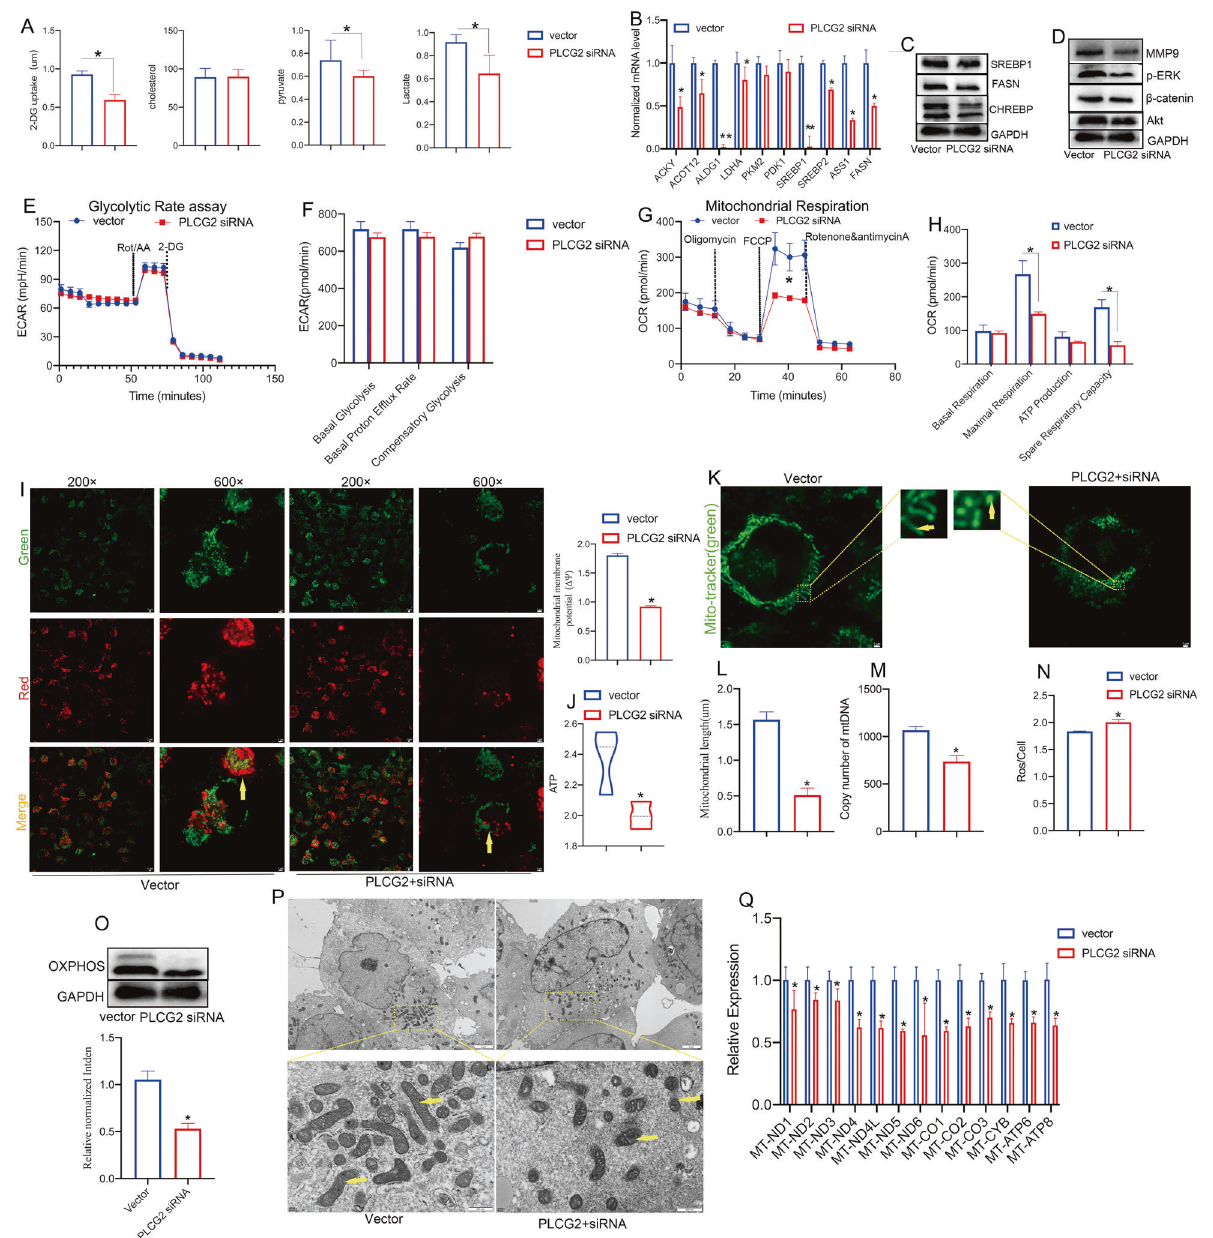
Fig. 5 PLCG2 knockdown induced mitochondrial dysfunction by regulating the ETC. A Glucose uptake, cholesterol, pyruvate and lactate production in H1299 cells after PLCG2 siRNA transfection. B , C The expression of metabolism-related genes in H1299 cells after PLCG2 siRNA transfection by qPCR and western blotting. D The levels of the metabolic reprogramming-related β -catenin/Akt signaling pathway components in H1299 cells after PLCG2 siRNA transfection, as shown by western blotting. E – H The glycolytic rate and mitochondrial respiration of H1299 cells after PLCG2 siRNA transfection, as determined by Seahorse XF. I The mitochondrial membrane potential (MMP, ΔΨ ) of H1299 cells after PLCG2 siRNA transfection by JC-1 staining. Scale bar = 600×. J Mitochondrial ATP synthesis in the PLCG2 siRNA group by the ATP detection kit. K , L The length of mitochondria in the PLCG2 siRNA group by MitoTracker Green staining and ImageJ software. M The number of mitochondria in the PLCG2 siRNA group as determined by mtDNA copy number count. N The production of reactive oxygen species (ROS) in the PLCG2 siRNA group. O The OXPHOS components in the PLCG2 siRNA group by western blotting. P Morphological changes in mitochondria in the PLCG2 siRNA group by TEM. Q The expression of ETC-related genes in the PLCG2 siRNA group by qPCR. Representative results from at least three independent experiments are shown. Data are represented as the mean ± SD of at least three experiments and statistically analyzed by Student ’ s t test or one-way ANOVA. * P <